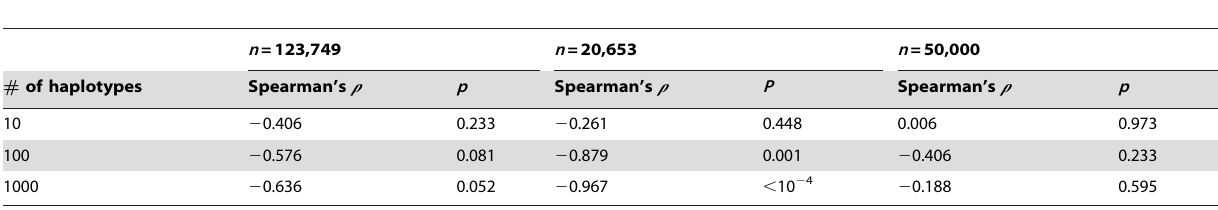
Table 2. Spearman’s rank correlation coefficients r between regional sub-files sizes and cumulated HF and corresponding p